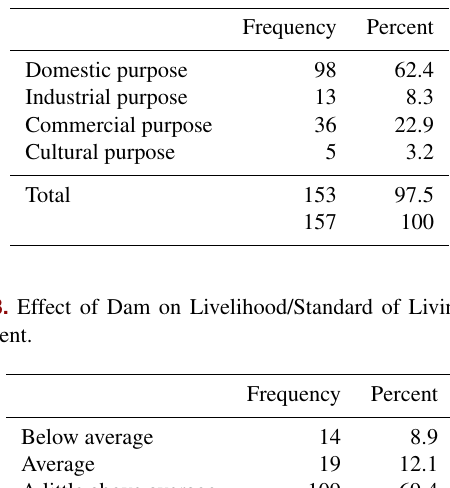
Table 1. Oyan Dam Landuse Dynamics between 1984 and 2016.